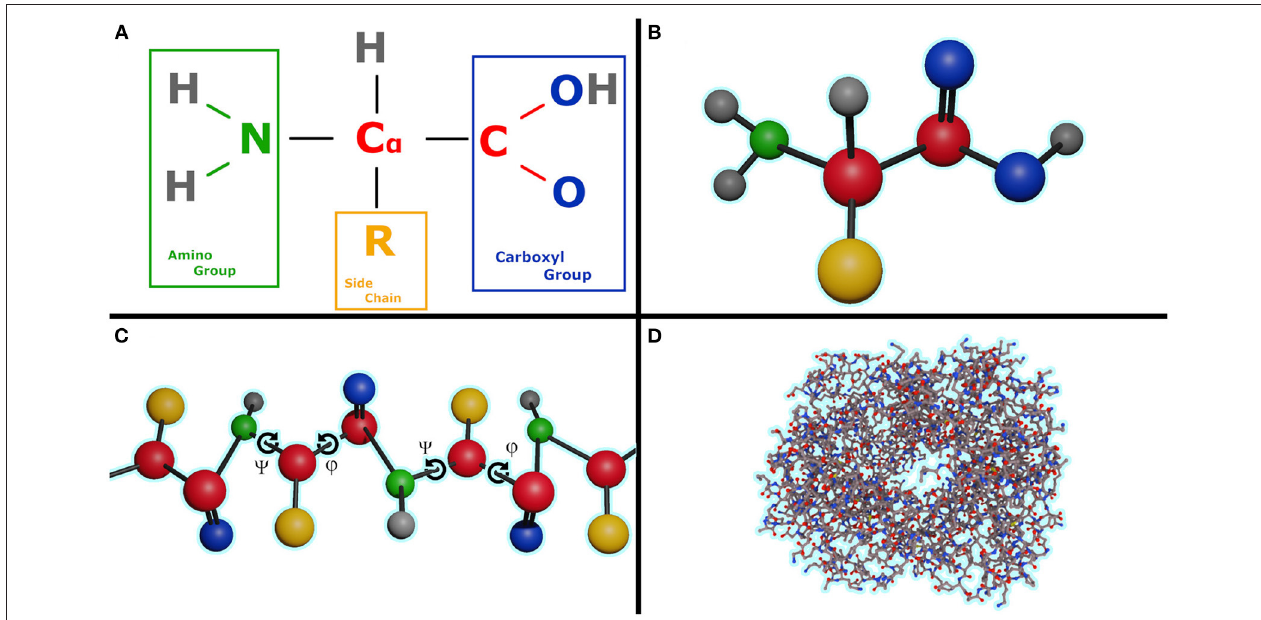
FIGURE 1 | (A) Formula of the amino acid, (B) Ball and stick representation of an amino acid, (C) Poly-peptide chain with illustrating the torsion angles ψ and ϕ for each amino acid in chain, (D) Human hemoglobin, 1GZX, ball and chain representation with an amino acid length of 141.